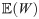
Capacity grows exponentially with module number.All plots show the dynamic coding range of our model (see Methods section). (a) Exact coding range of the grid code for variables of dimension 3 to 6, assuming an overly conservative phase resolution of Δ = 0.2 to reduce time of computation. We show the geometric mean and standard deviation over 1000 different draws of the projection matrices A for each pair M, N. The entries of the matrices are sampled independently from a standard normal distribution. To compute the expected value E(W) of the benchmark in Eq 3, we also run this simulation with N = 1 (S1 Fig), solid line. The capacity grows exponentially with the number of modules; the benchmark provides an estimate of the expected capacity. (b) We use the benchmark to show the coding range for more realistic values of phase resolution (Δ = 0.2, …, 0.025). We chose the benchmark rather than measuring the exact range for practical reasons (the run-time scales with the volume of the coding range not its side-length). Results shown for M/N ≥ 1.